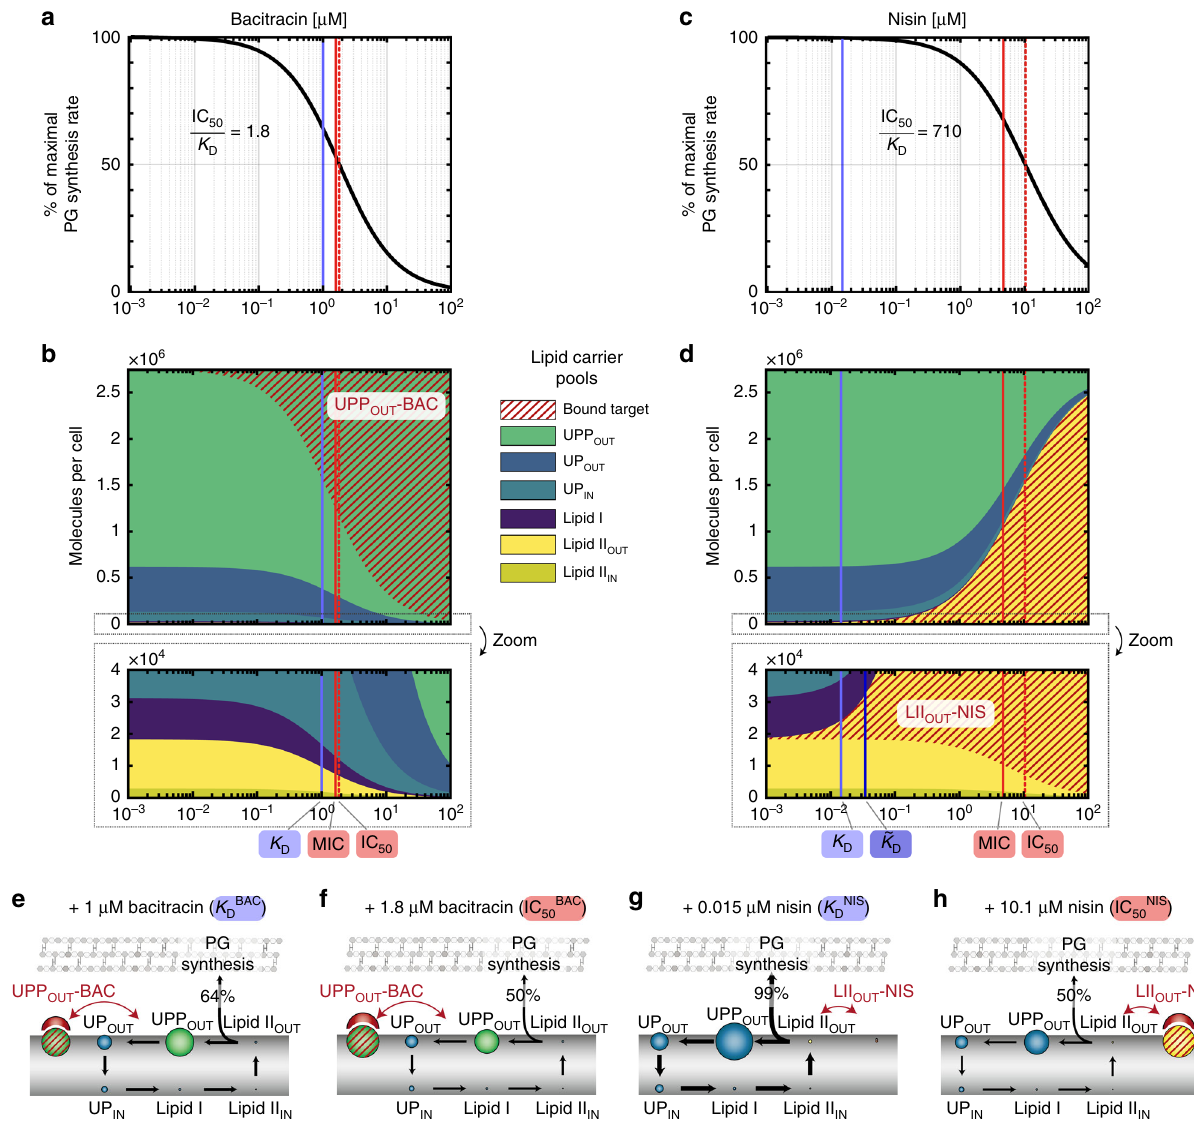
Fig. 3 The asymmetric distribution of lipid II cycle intermediates can generate a massive in vivo ef fi cacy gap in B. subtilis . a , c Model prediction of the PG synthesis rate (black lines) for varying bacitracin ( a ) and nisin ( c ) concentrations. Blue lines indicate the in vitro dissociation constants K D and red solid lines the experimental MICs derived from literature (see Supplementary Table 4 for parameter values and references). The red dashed line indicates IC 50 value predicted by the model, i.e. the concentration at which the PG synthesis reaches 50% of the maximal rate. b , d Model prediction of the pool levels of lipid II cycle intermediates at different bacitracin ( b ) and nisin ( d ) concentrations. e – h Schematic illustrations of pool level distributions at bacitracin and nisin concentrations corresponding to the respective K D and IC 50 values. e At a bacitracin concentration equal to the K D value, the external UPP pool is signi fi cant reduced, implying ef fi cient sequestration of high levels of lipid II cycle intermediates from the cycle, thereby decreasing all free cycle intermediates, especially lipid II. While this already reduces the rate of PG synthesis to a level of 64% of its maximum, only slightly higher bacitracin concentrations ( f ) are required to reduce the rate of PG synthesis to 50%. g In contrast, although nisin — at a concentration around the K D — binds 50% of the free lipid II pool, this only sequesters ~1% of all lipid intermediates from the cycle. As the remaining lipid carriers quickly replenish the free form of lipid II molecules by on-going cycling, the rate of PG synthesis is not reduced signi fi cantly (99% of maximum). h Eventually, high concentrations of nisin are required at the IC 50 value to sequester ~50% of the total lipid II cycle intermediates into nisin-lipid II complexes, in order to decrease the pool of free lipid II pool and the PG synthesis rate to 50%. For an analysis of the remaining three antibiotics please refer to Supplementary Fig.